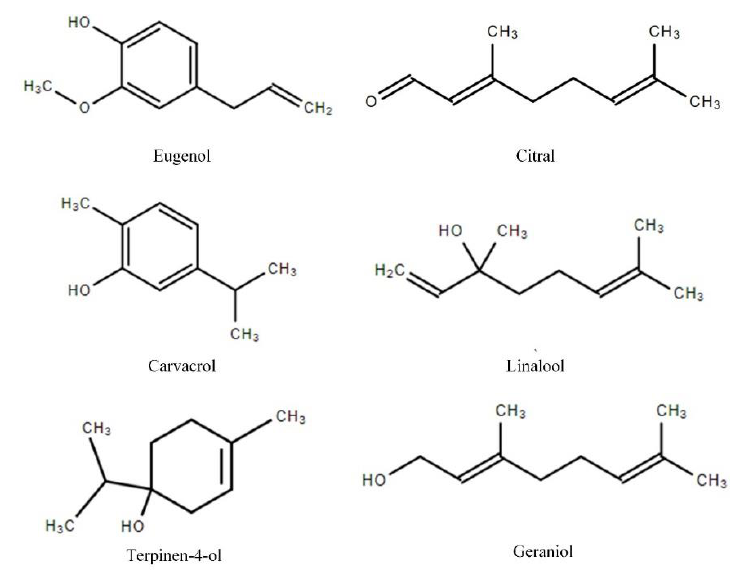
Figure 3. Molecule structures of the six terpenes.